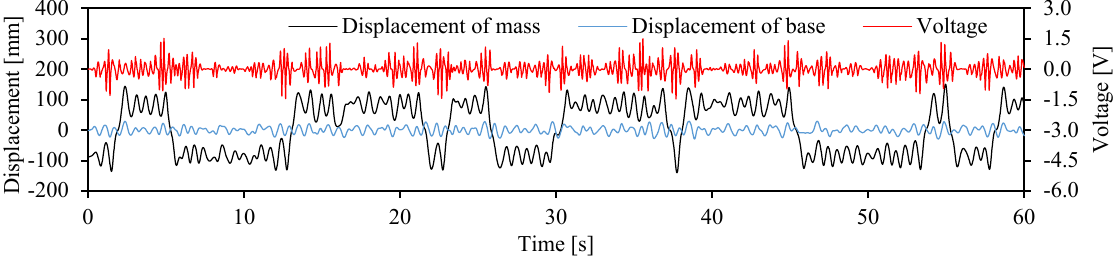
When the periodic signal frequency was 1.3 Hz, as shown in Figure 19, the vibration of the mass block became more intense, and a stochastic resonance phenomenon occurred that caused the monostable vibration of the mass block to evolve to a bi-stable vibration with standard deviations of 77.64 and 10.85 mm in the vibration displacements of the mass block and support point, respectively; consequently, 2.08 mW of power was output. Meanwhile, at a higher periodic signal frequency of 1.6 Hz, the mass block vibrated more intensely, as shown in Figure 20, and the number of occurrences of bi-stable vibra- tion increased, indicating that stochastic resonance is most likely to occur in this excitation frequency range. The standard deviations of the vibration displacement of the mass block and support point were 83.47 and 11.53 mm, respectively, which resulted in 3.51 mW of Figure 19. Results based on co-excitation of random and 1.3 Hz periodic signals. power generated. Figure 20. Results based on co-excitation of random and 1.6 Hz periodic signals.